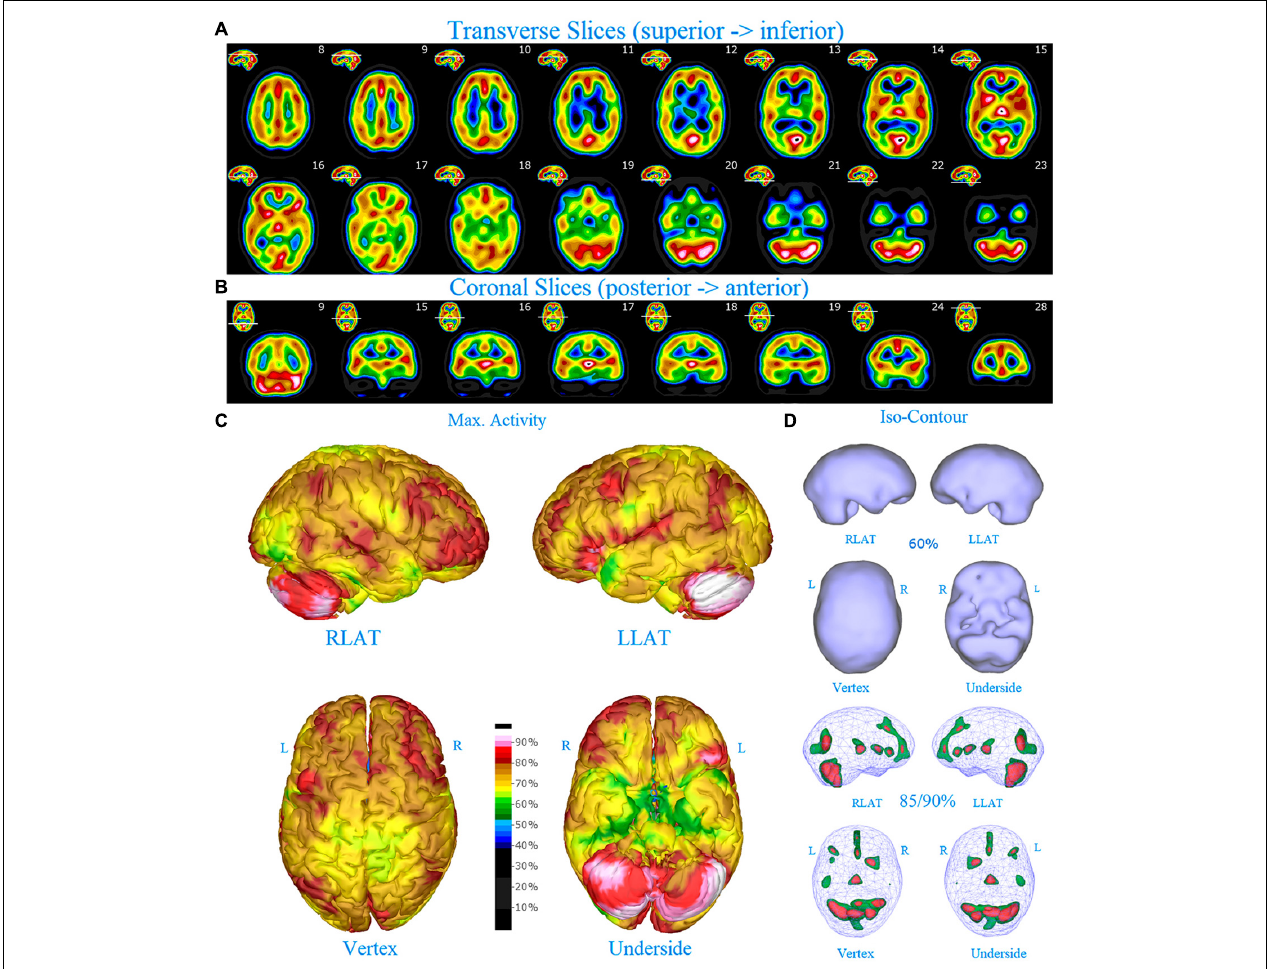
FIGURE 1 | Perfusion SPECT scan of normal control. (A) Horizontal tomograms from a 99 m Tc-HMPAO perfusion SPECT scan spanning much of the brain from near superior surface to lower cerebellum (see locator images). (B) Coronal tomograms spanning from anterior margin of cerebellum to anterior cingulate (see locator images). The color scale is scaled relative to the patient’s mean cerebral perfusion. Mean blood flow (72%) is in yellow. Color shifts occur at approximately every 0.5 SD (3%) relative to the patient’s mean. Details of the brain can be appreciated, including the thalamus, head of the caudate nuclei, lentiform nuclei, anterior cingulate gyri, and distinct cortical regions. The perfusion of the thalamus (white with black central dot), right caudate (on the left side of the tomogram), visual cortex and cerebellum are highest in this example. (C) The modern SPECT scan displayed in 3-dimensional reconstruction. Right lateral (RLAT), left lateral (LLAT), Vertex, and underside views are provided. The color scale is the same as panel (B) . (D) Isocontour representations of the SPECT data in 3 dimensions. Surface isocontour representations allow visualization of areas of decreased cortical perfusion. Areas in which perfusion falls below 60% of the maximal cerebral blood flow appear as depressions or holes depending on how far below 60% the perfusion falls. Wireframe representations allow visualization of areas of increased perfusion. Areas with perfusion at 85% of the maximal cerebral blood flow appear in green, while areas at 90% of maximal cerebral blood flow appear in red. It is evident that the thalamus, right caudate, cerebellum, and visual cortex are perfused at 90% of maximal cerebral blood flow. This corresponds to what is seen in the